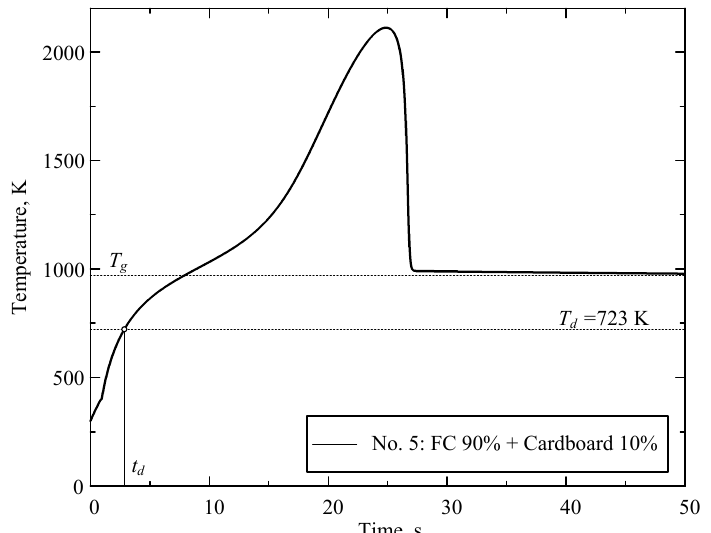
Figure 5. Establishing ignition-delay times by the CLF droplet temperature evolution as illustrated by composition No. 5 (FC 90% + cardboard 10%) at T g = 973 K, V g = 0.